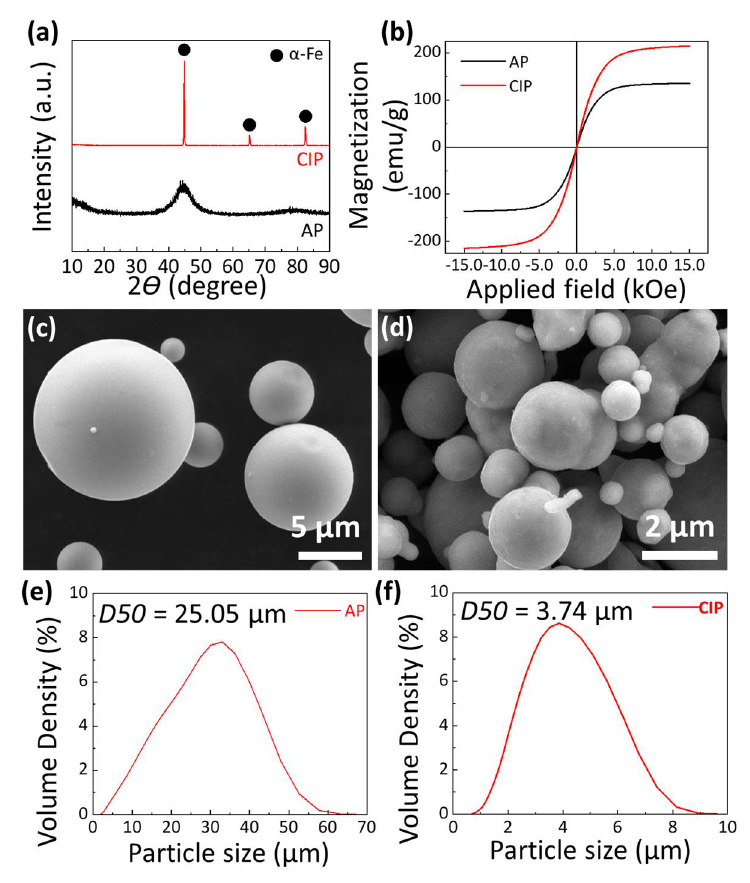
Figure 1. ( a ) XRD patterns of amorphous powder (AP) and carbonyl-iron powder (CIP). ( b ) Magnetic hysteresis loops of amorphous powder and carbonyl-iron powder. ( c , d ) SEM surface images of ( c ) amorphous powder and ( d ) carbonyl-iron powder. ( e , f ) Particle size distribution of ( e ) amorphous powder and ( f ) carbonyl-iron powder. The D50 is the volume